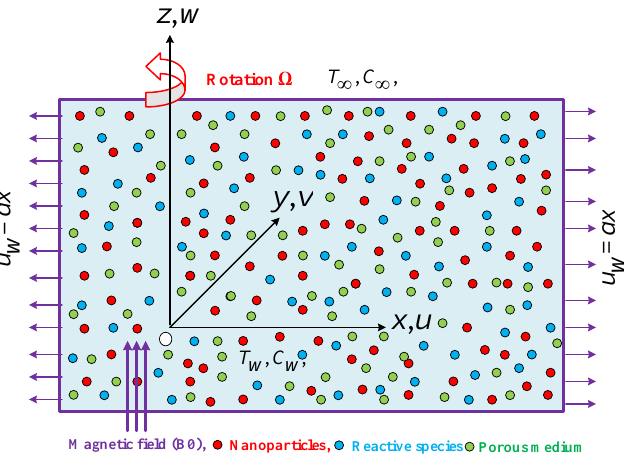
Figure 1. Physical model and coordinate